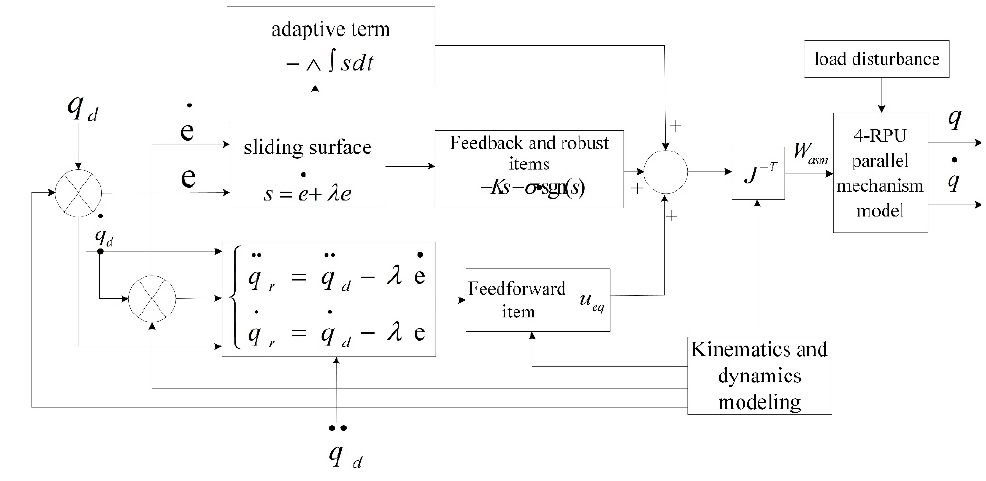
Figure 6. 4-RPU parallel topology schematic diagram.